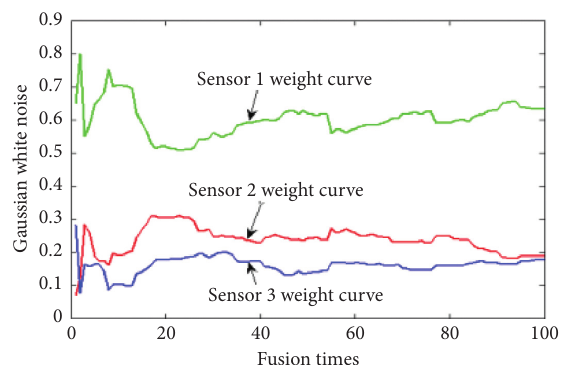
Figure 5: Weight curve of the sensor before improvement.